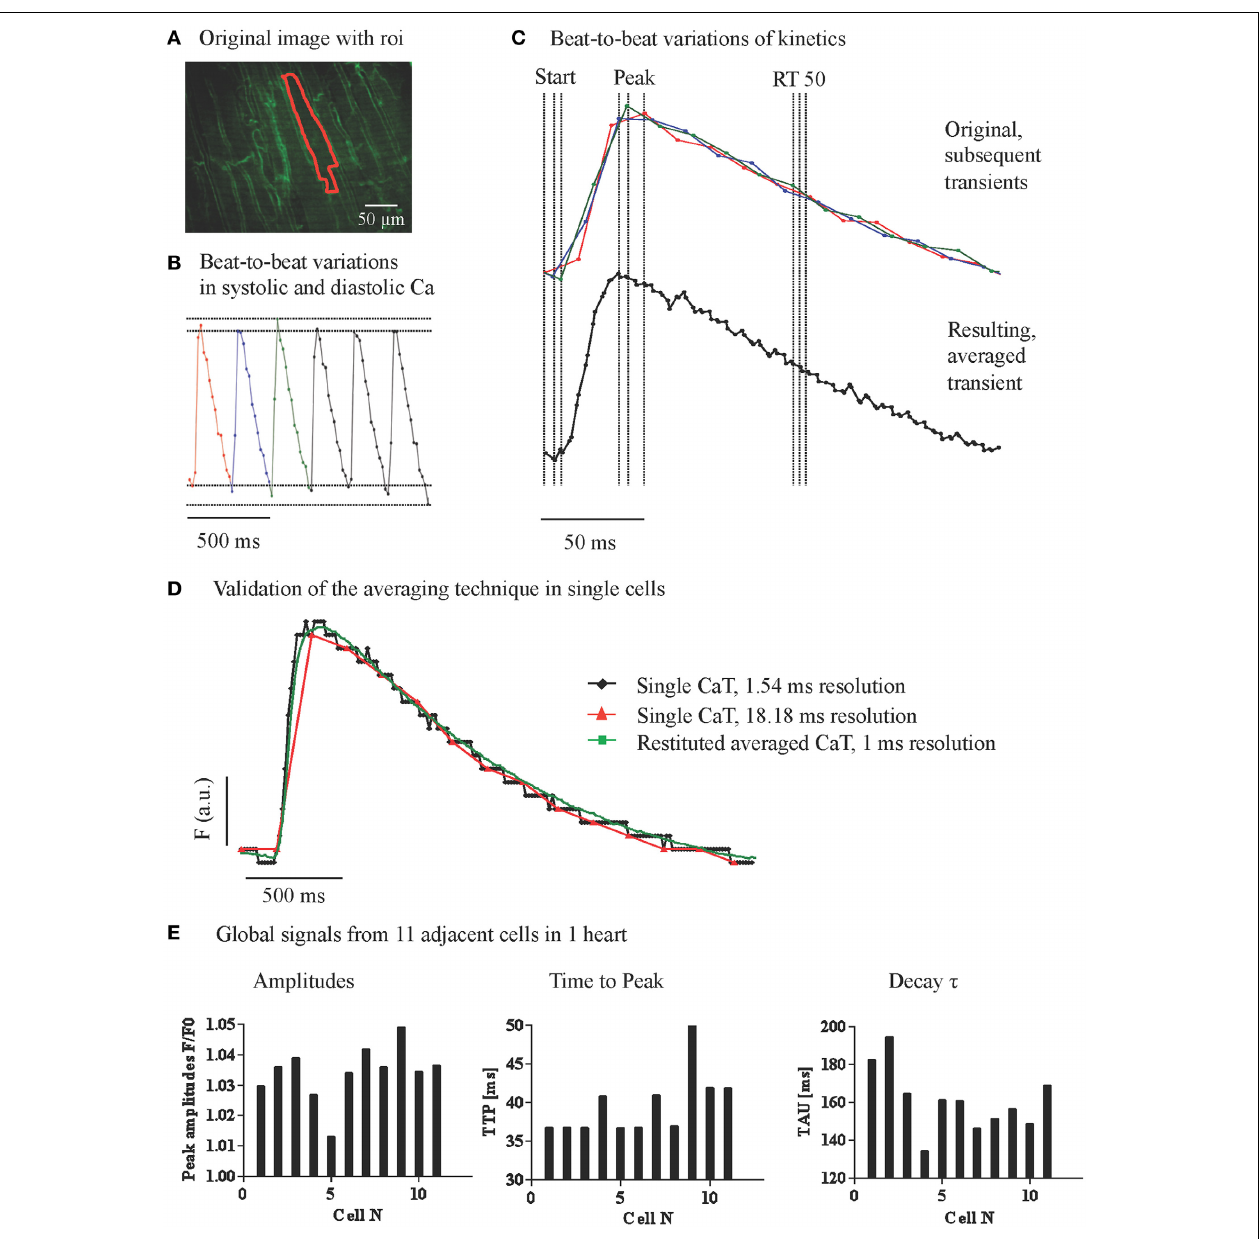
FIGURE 2 | Variations of global cytosolic Ca transients between adjacent cardiac myocytes. (A) Confocal image of the epicardial layer of a Langendorff-perfused mouse hearts, loaded with Ca indicator Fluo-8 and the membrane dye Di-4-ANEPPS. Ca transients were recorded at 18ms/frame with a Nipkow 2D confocal microscope and the Ca signals from adjacent myocytes were extracted. (B) The raw signal of Ca transients showed beat to beat fluctuations due to undersampling of the rapid change in intracellular Ca. (C) Data points